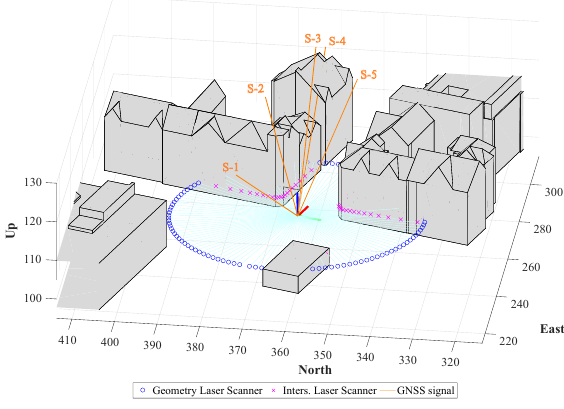
Figure 1. Example of the simulation geometry containing the Level of Detail 2 (LoD-2) city model (grey), the simulated laser scanner rays (blue) and their intersections with the city model (magenta) as well as the GPS line-of-sight vectors